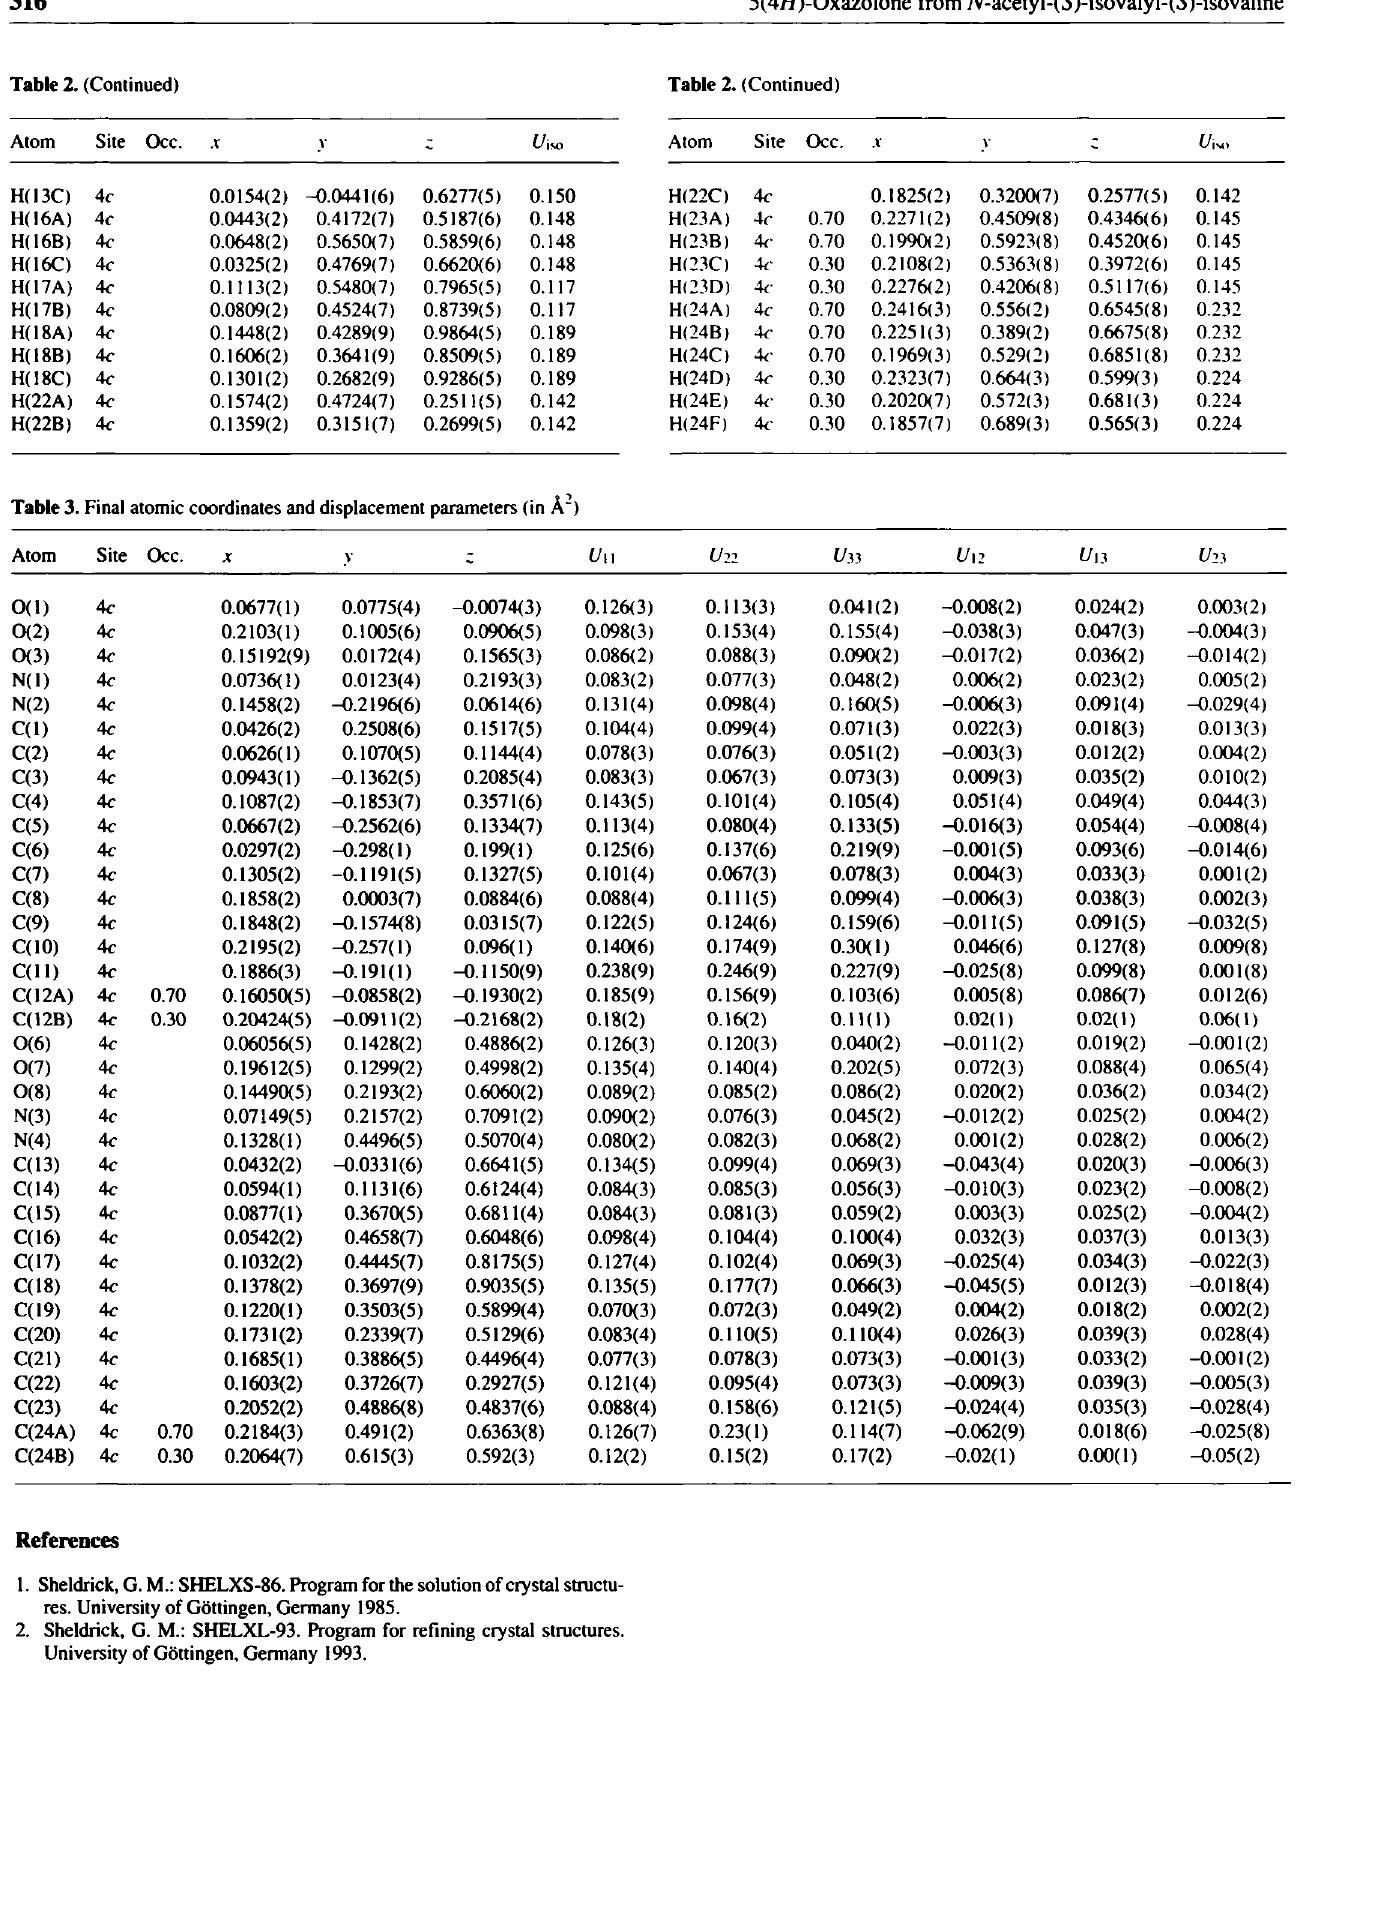
Table 3. Final atomic coordinates and displacement parameters (in